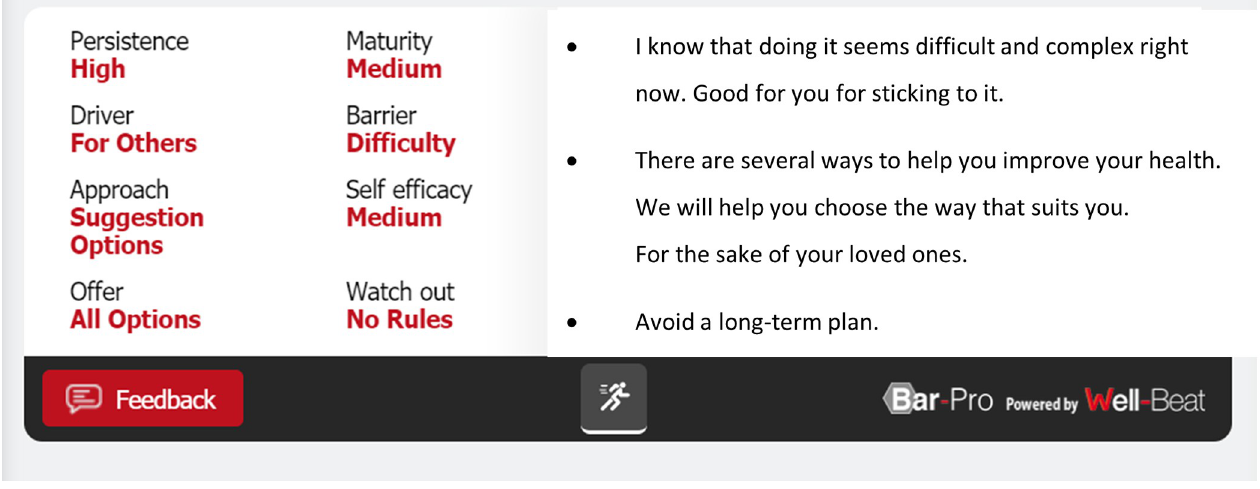
Fig 1. Example of the HCP toolbar for a particular